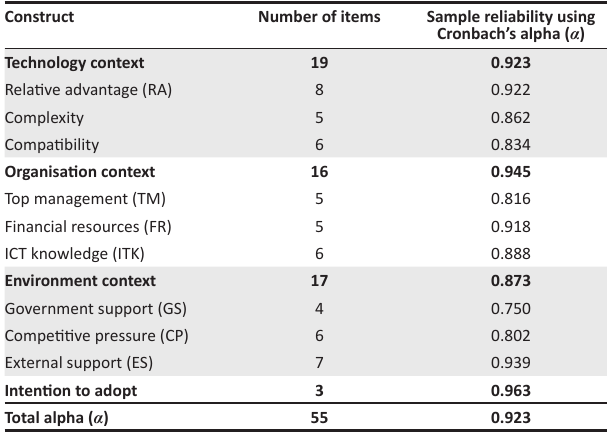
TABLE 1: Test of reliability of technology, organisation and environment constructs.